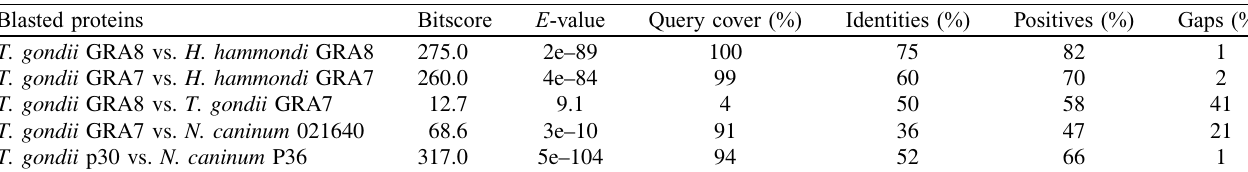
Table 3. Protein BLAST analysis.